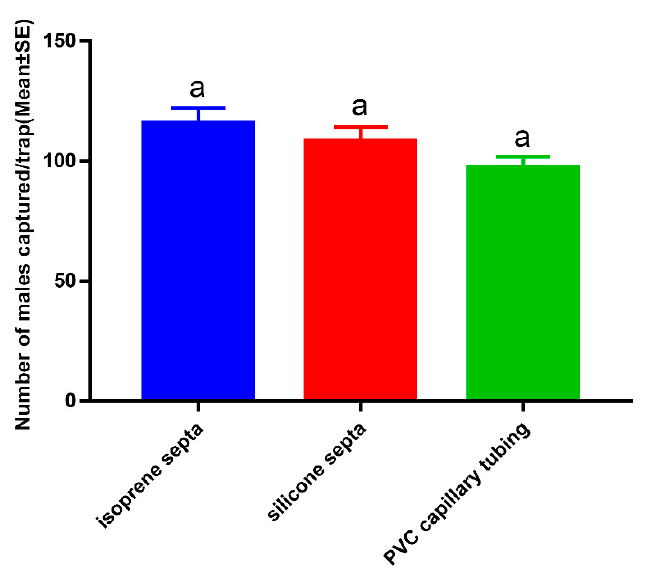
Figure 5. Effect of sex pheromone dispensers on catch of Ectropis grisescens male moths. Bars mean standard error. Different letters indicate significant difference (Tukey’s HSD test, p < 0.05).